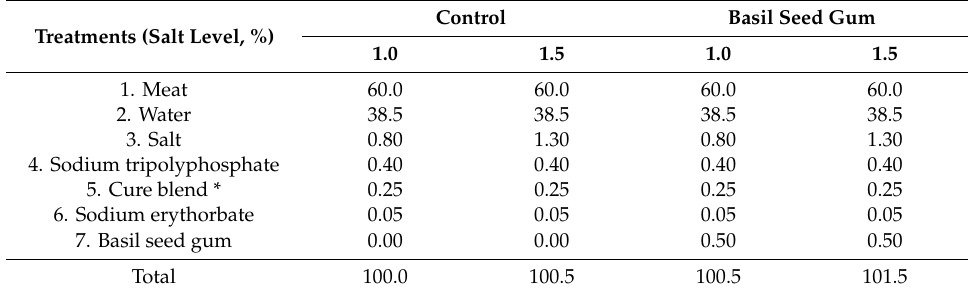
Table 2. Formulation for the manufacture of low-fat sausages with basil seed gum at di ff erent salt levels. Treatments (Salt Level,